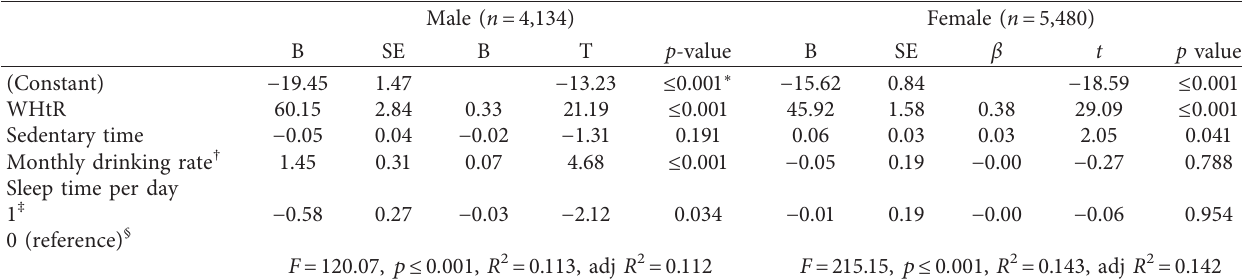
Table 4: Sex differences in the factors associated with the 4-year estimated incidence of T2DM in Korean adults ( n �